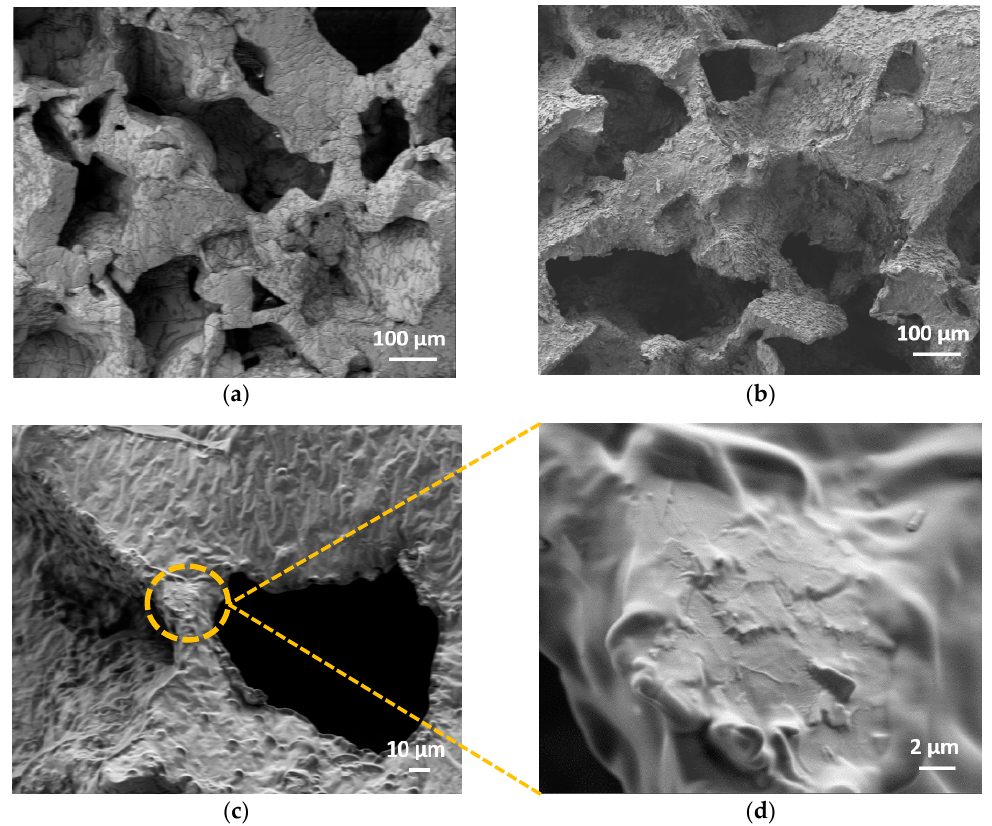
Figure 4. Cross section of an Ecoflex ® foam (EF) sample ( a ) and an EF-3% ( b ). Magnification of the EF-3% foam ( c ) and the detail of some embedded and partially emerging GNPs ( d ).